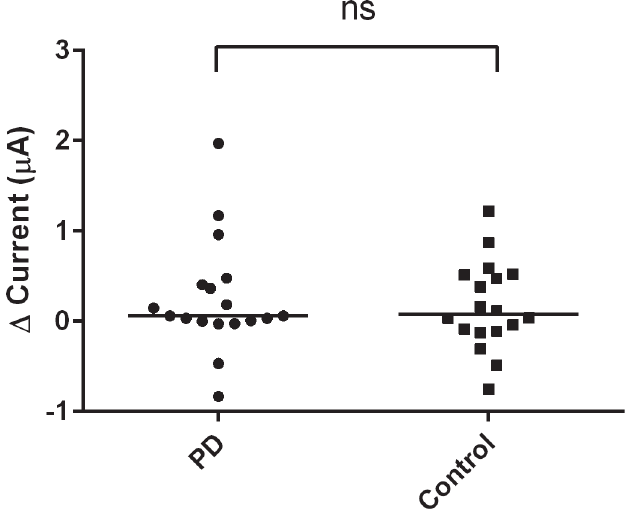
Fig 6. Change in EG-ISFET biosensor currents for PD and control saliva samples. The change of current generated from the PD and control groups. Data are presented as median. * p (cid:1) 0.05; ns = not